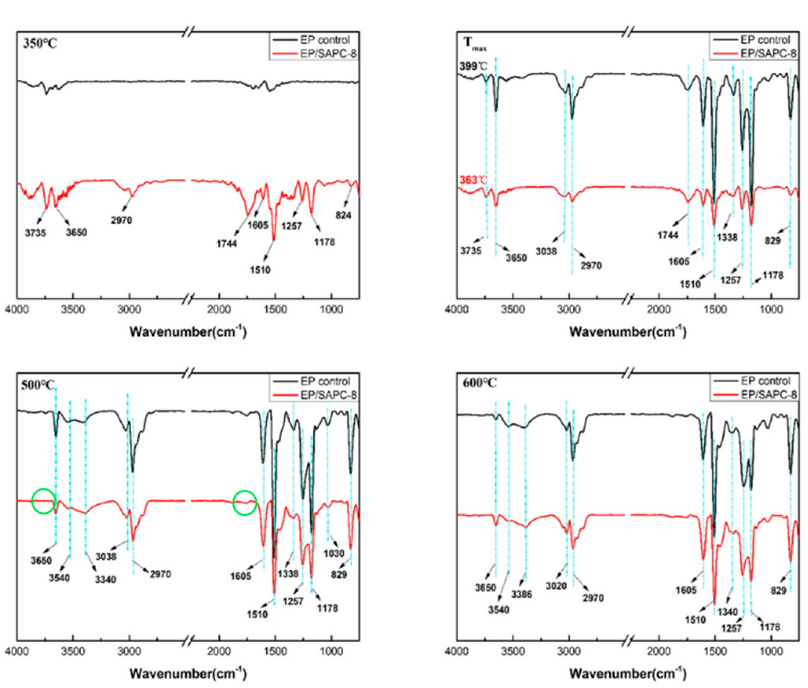
Figure 10. FTIR spectra of the pyrolysis products of the EP control and EP/SAPC-8 at 350 °C, T max , 500 °C, and 600 °C.